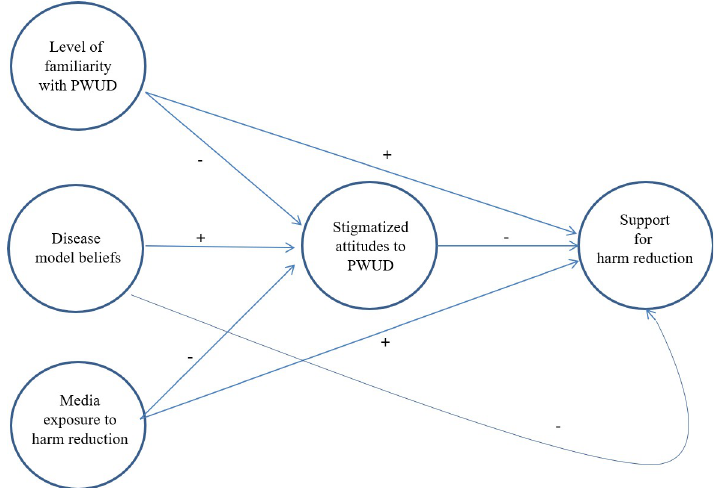
Fig 1. Hypothesized social exposure model of public support for harm